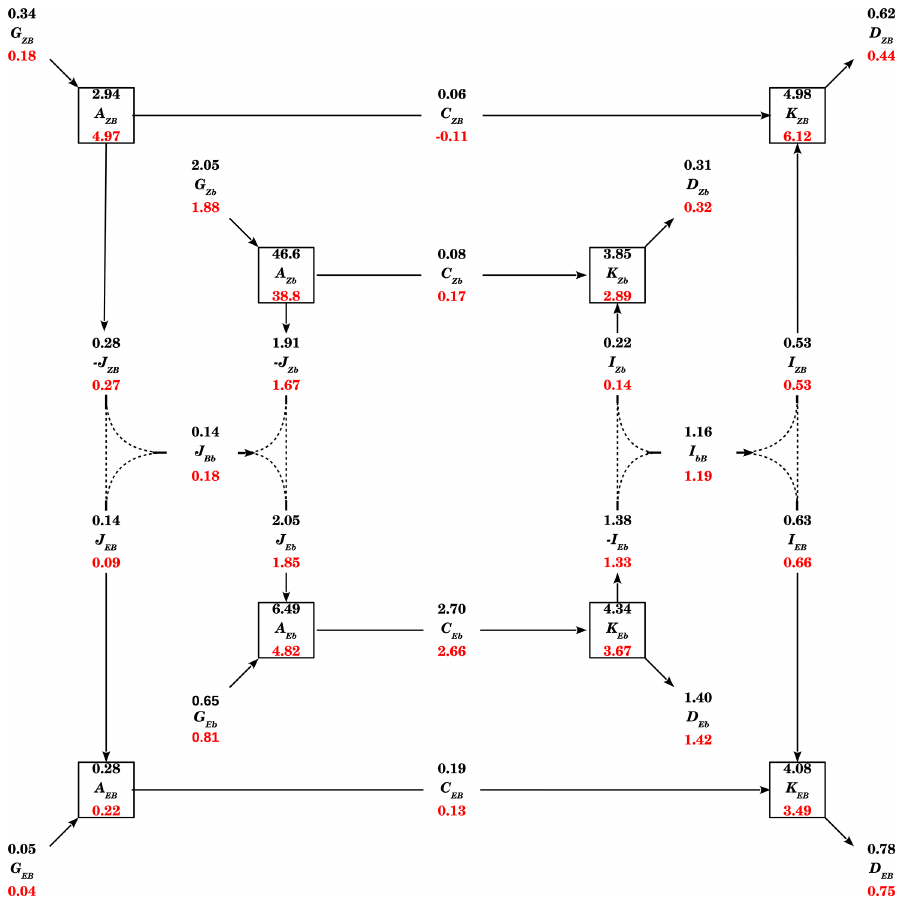
Figure 10. Extended energy cycle diagram describing the flow of energy among the zonal mean and eddy components and among the barotropic and baroclinic components for ERA-Interim in DJF (top values) and JJA (bottom values) climates. Units are 10 5 Jm − 2 for energy levels and Wm − 2 for conversion and transfer rates and generation and dissipation